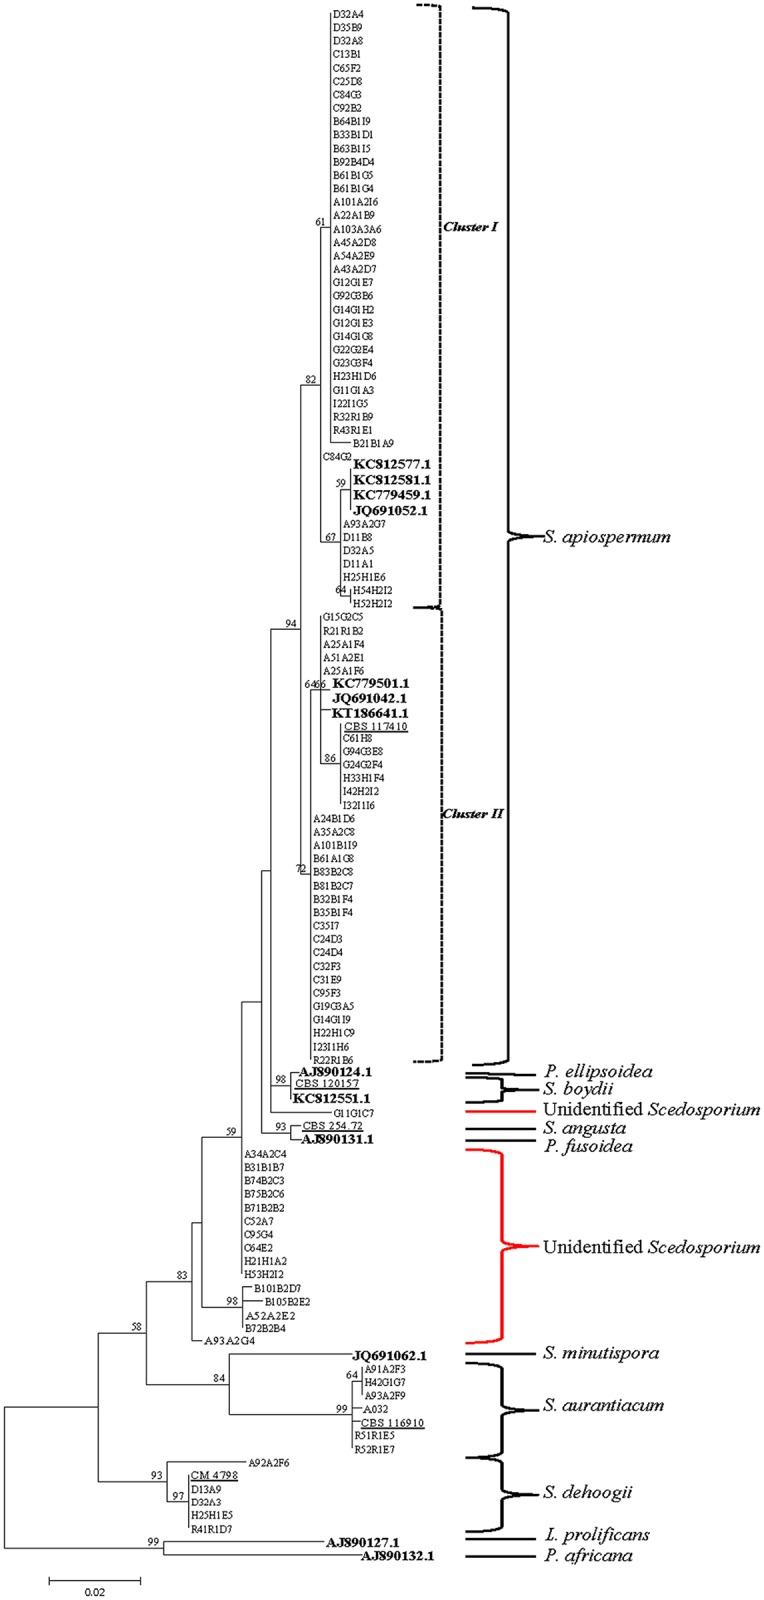
Maximum-likelihood tree of β-tubulin gene sequences of Scedosporium isolates and reference strains.The tree recovered under the Tamura–Nei model with the highest log likelihood (−1,599.6719) is shown. The tree is drawn to scale, with branch lengths corresponding to the number of substitutions per site. Bootstrap values ≥ 50% (1,000 replicates) are shown above branches. Accession numbers of Scedosporium sequences retrieved from GenBank are shown in bold; accession numbers of standard strains are underlined. Lomentospora prolificans and Pseudallescheria africana were used as outgroups. Genus abbreviations are as follows: L, Lomentospora; P, Pseudallescheria, S, Scedosporium.